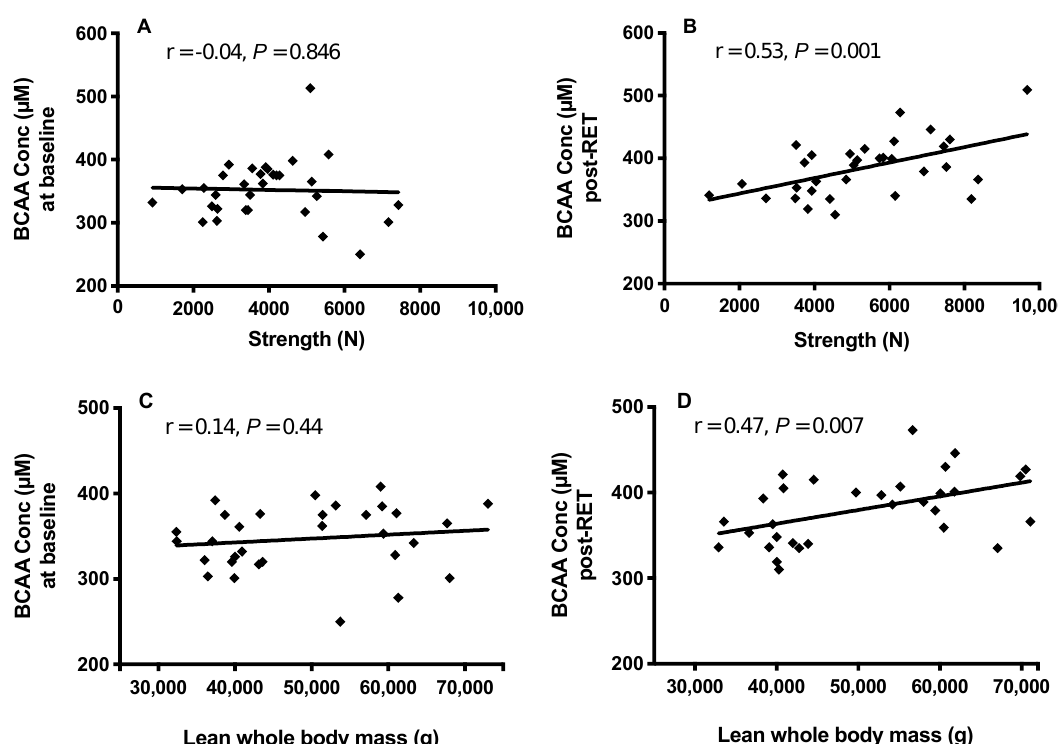
Figure 5. The relationship between circulating branched chain amino acid (BCAA) concentrations and muscle strength ( A , B ), mass ( C , D ) and body fat percentage ( E , F ) at baseline and after 20 weeks, fully- supervised, whole-body resistance exercise training (RET) ( n = 32).